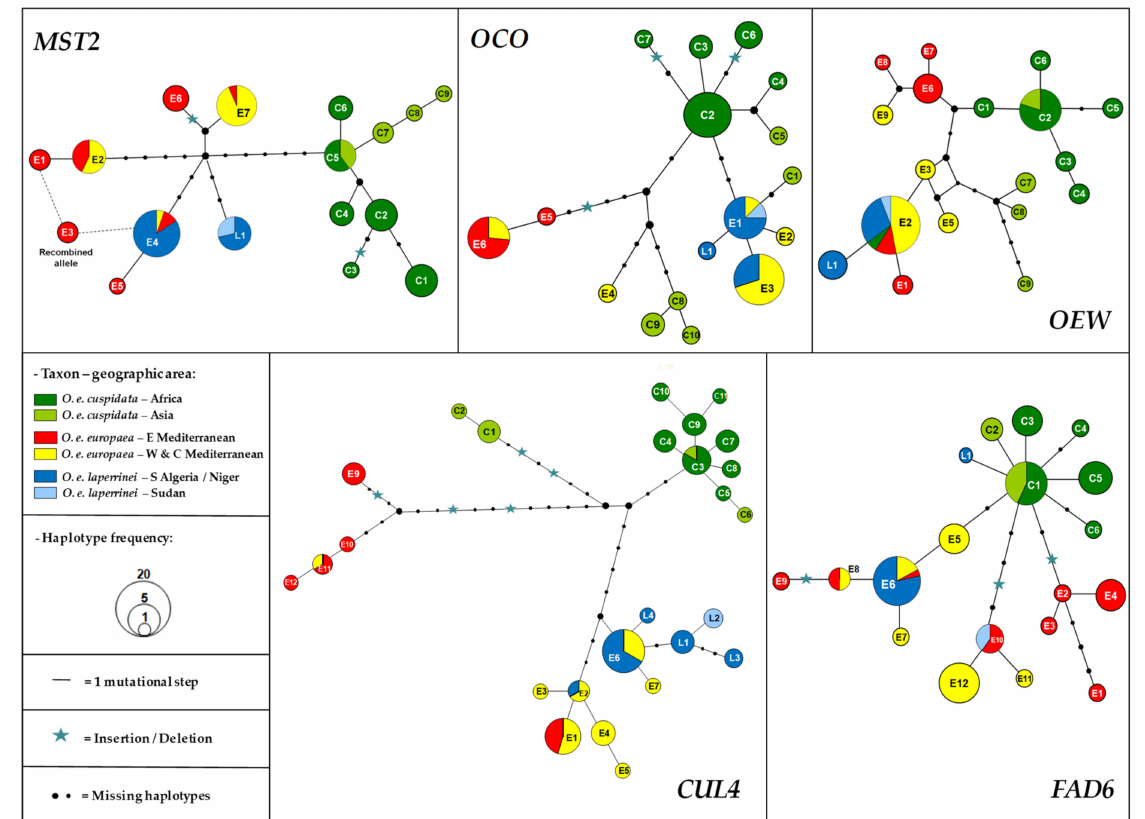
Figure 1. Reduced-median haplotype networks reconstructed for five nuclear loci with N ETWORK [44]. Each haplotype is numbered and represented by a pie chart. The size is proportional to the number of occurrences within our sampling. Haplotype data of Mediterranean and African wild olives are from [36]. MST2 -E3 was identified as a recombinant allele [36]. The origin of haplotypes is indicated by a specific